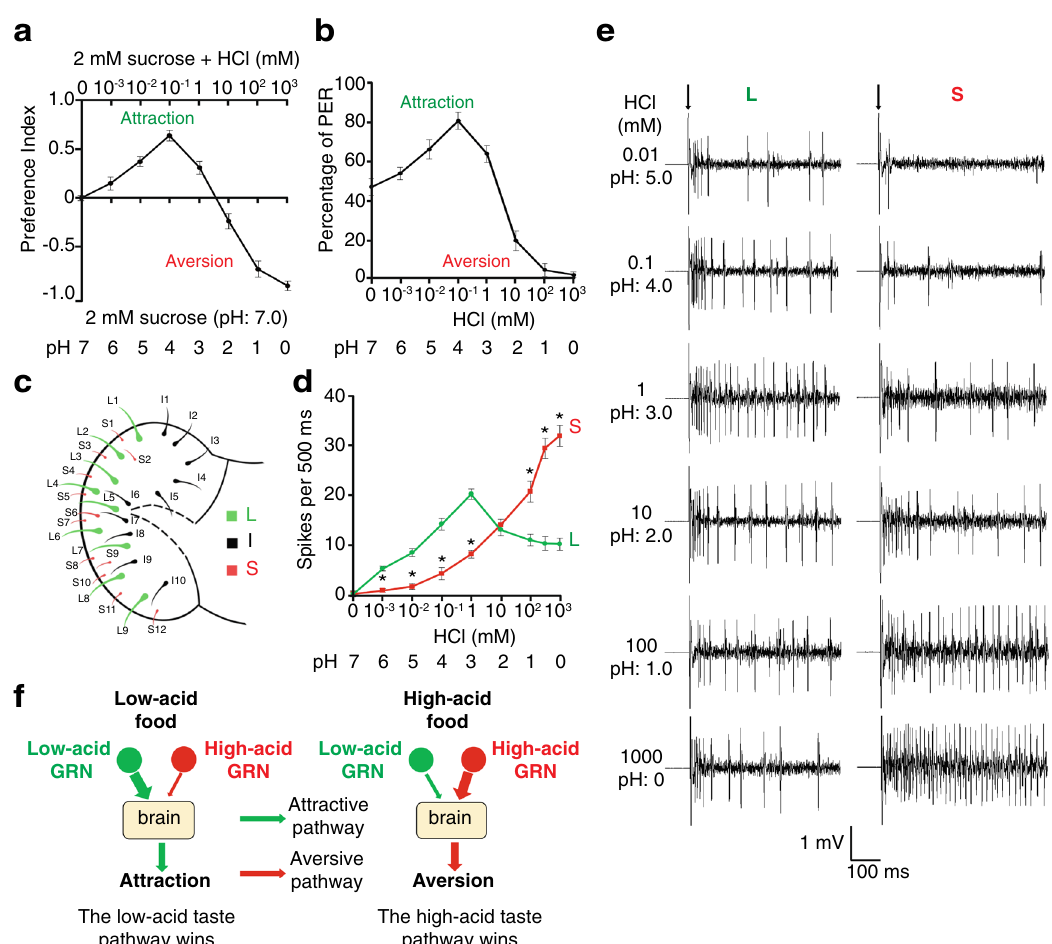
Fig. 1 Gustatory responses to varying acid concentrations in distinct types of taste sensilla. a Feeding responses when choosing between 2 mM sucrose (pH 7.0) and 2 mM sucrose plus varying HCl concentrations (0.001 – 1000 mM). n = 12 trials, with about 70 animals tested in each trial. Data are presented as mean ± SEM. b Proboscis extension re fl ex (PER) in response to 30 mM sucrose food mixed with varying HCl concentrations. n = 12 trials (pH 3 – 6), n = 11 trials (pH 0 – 2), and n = 10 trials (pH 7). In each trial, at least ten animals were tested. Data are presented as mean ± SEM. c Distribution of taste sensilla on the proboscis, showing large (L), small (S), and intermediate (I) types. d Firing rates of L6 and S5 sensilla in response to a series of HCl concentrations. Data are presented as mean ± SEM. n = 10 animals, * p < 0.0001 (0.001, 0.01, 0.1, 1, and 1000 mM) and * p = 0.0006 (100 mM), unpaired two-tailed t -tests. e Representative action potentials evoked by a broad range of HCl concentrations at L6 and S5 sensilla. Arrows indicate the onset of taste stimuli. f Competition model of acid-taste